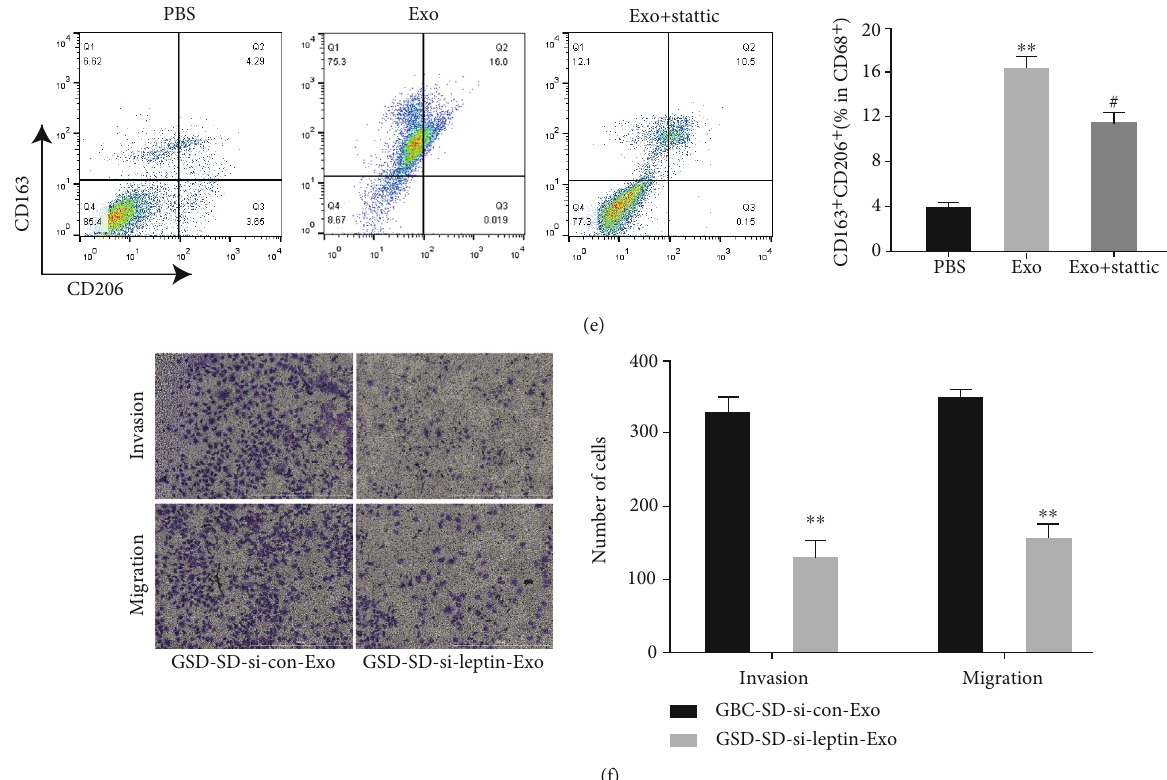
Figure 4: Exosome-enclosed leptin promotes macrophage to M2 subtype via STAT3. (a) Western blot assay showed the expression of STAT3 and p-STAT3 in macrophage with PBS or GBC-SD cell-derived exosomes. The p-STAT3 expression was quanti fi ed. (b) Western blot assay showed the expression of STAT3 and p-STAT3 in macrophage treated with exosomes form si-control or si-leptin-transfected GBC-SD cell. The p-STAT3 expression was quanti fi ed. (c) Western blot assay showed the expression of STAT3 and p-STAT3 in macrophage treated with exosomes form PBS, Exo or Exo+statti-transfected GBC-SD cell. The p-STAT3 expression was quanti fi ed. (d) qRT-PCR to detect the speci fi c markers for M2-subtype macrophages in macrophage treated with PBS, or exosomes, or STAT3 inhibitor static. (e) Flow cytometry determining the percentage of CD163 + CD206 + cells among total CD68 + cells after induction. (f) Transwell assay to detect invasion and migration of exosome- or static-treated GBC-SD cell. Invasion and migration of GBC-SD cell were quanti fi ed. Data in (a – f) are representative of three independent experiments; the P value was determined by Student ’ s t test or one-way